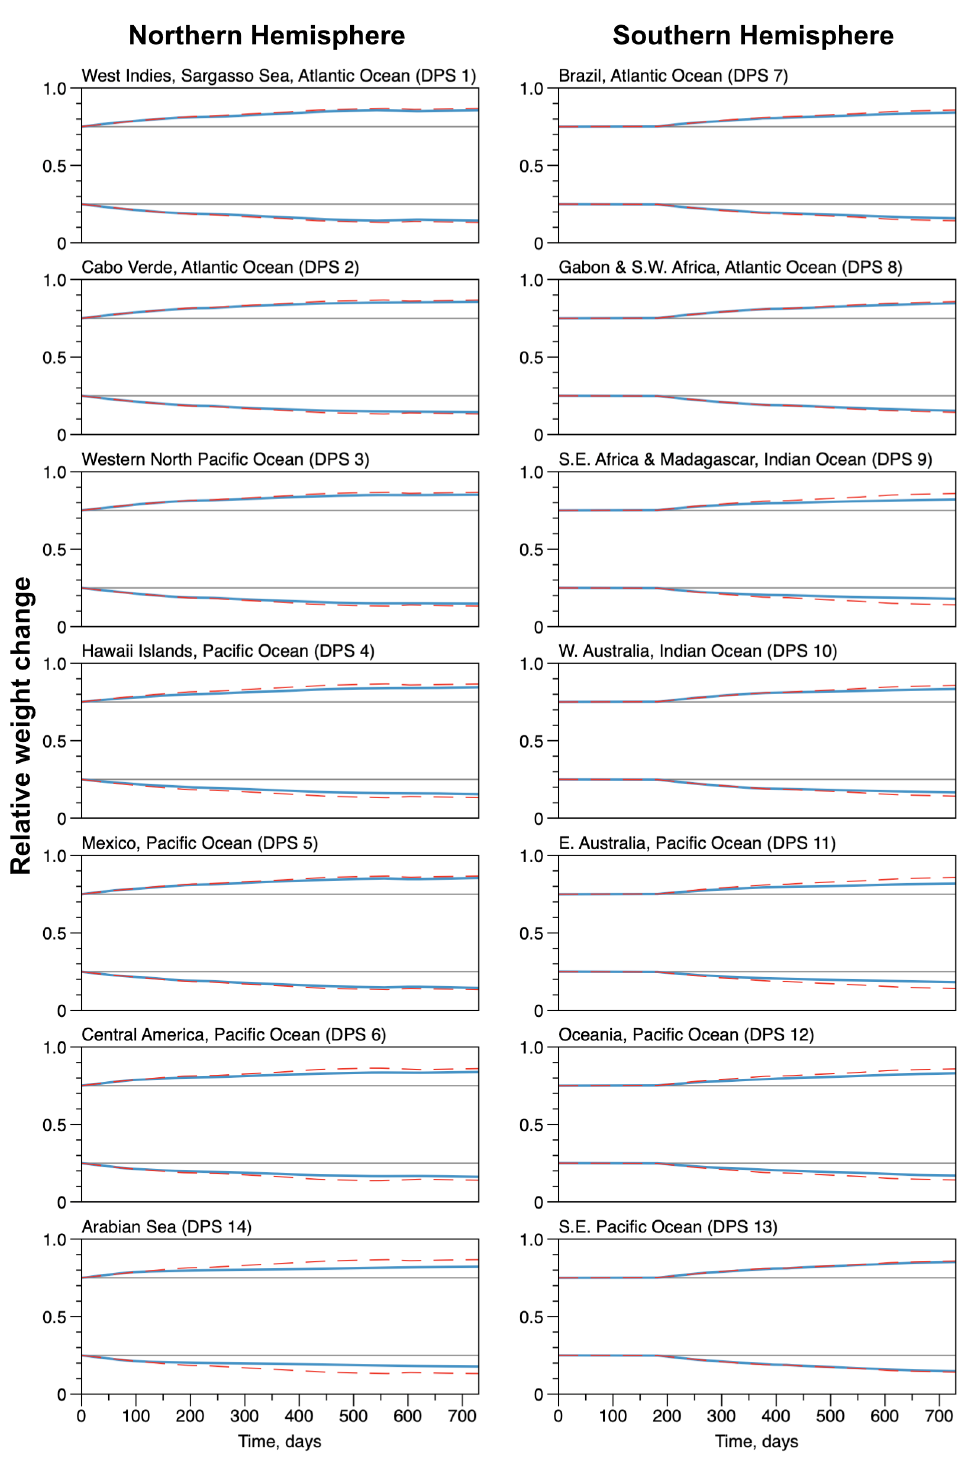
Figure 9. Average weight proportion for the groups of whales in each Distinct Population Segment. The lower line groups (below 0.5) are the ratio between the blubber and the total weight. The upper line groups (above 0.5) are the remaining body compartments (organs, bones, gut) divided by the total weight. The red dashed lines result from simulations with the constant ocean depth and no coastlines, the blue solid lines are from simulations with the actual ocean bathymetry. The nominal ratios (0.25 and 0.75) are also plotted as dotted gray